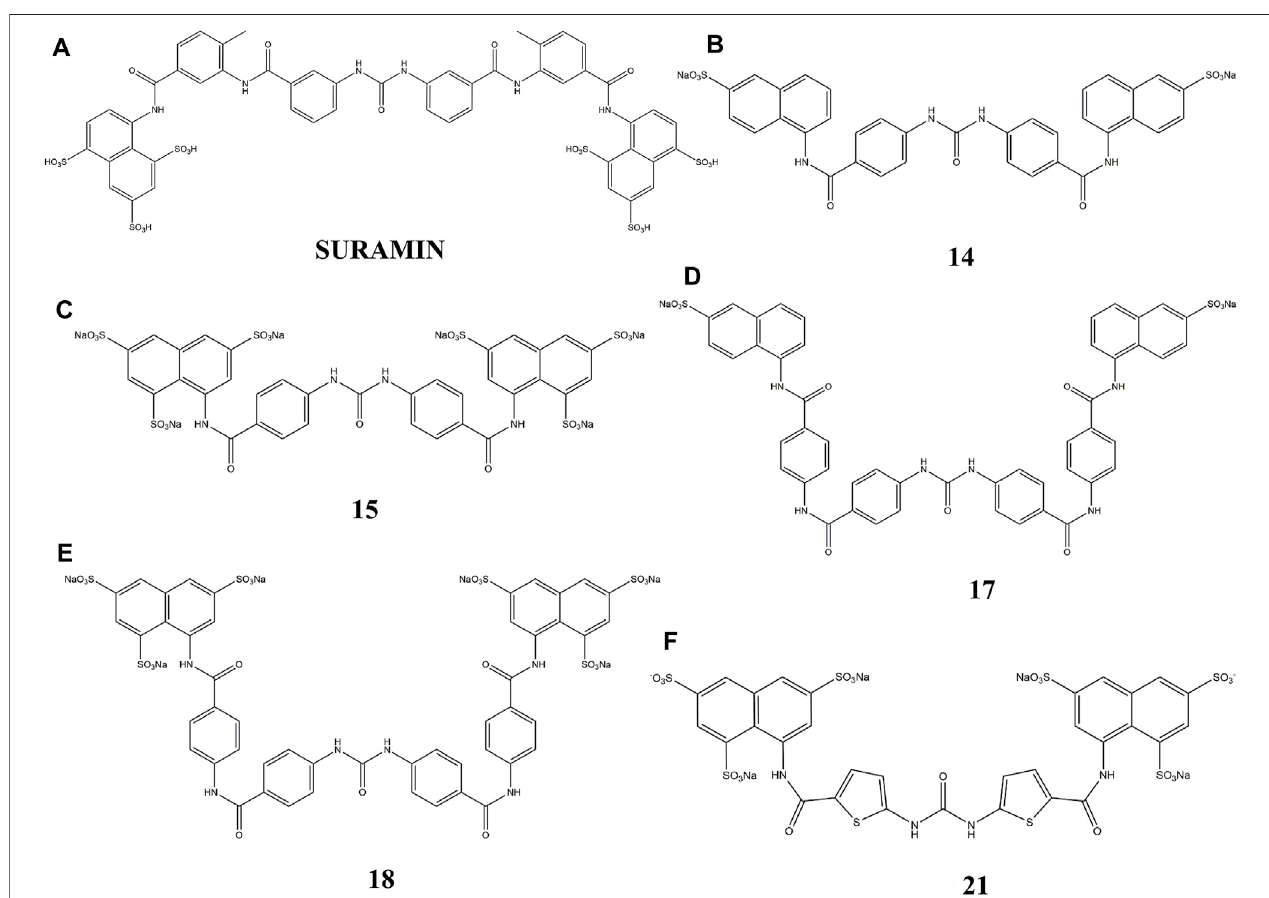
FIGURE 1 | Chemical structure of suramin and its fi ve derivatives (compounds 14, 15, 17, 18 and 21 ).